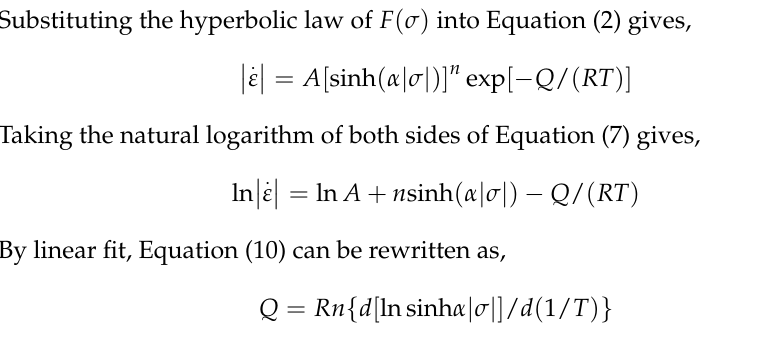
(cid:12) (cid:12) (cid:12) (cid:12) . . ε ε (cid:12) (cid:12) and ln | σ | ; ( b ) ln (cid:12) (cid:12) and | σ | .